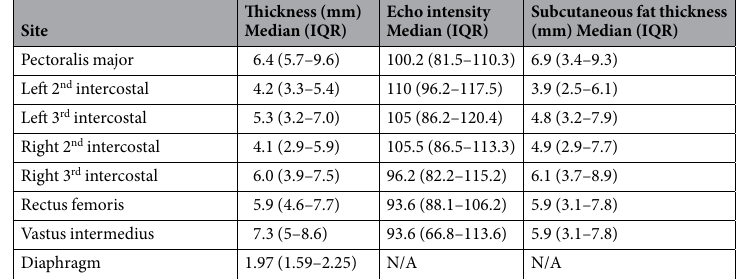
Table 2. Ultrasound Findings. IQR – interquartile range.